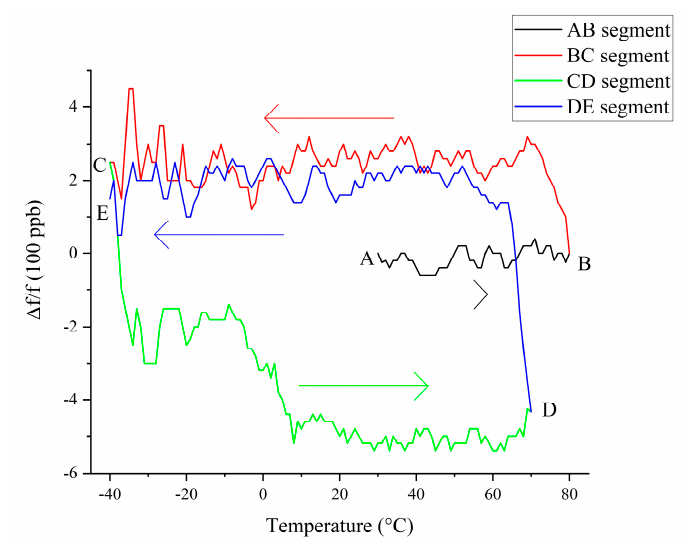
Figure 9. Thermal hysteresis curve after smoothing.